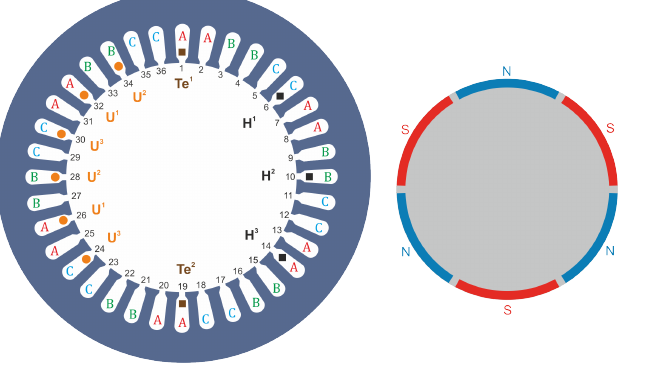
Figure 6. Illustrative drawing showing our developed construction of a BLDC motor: left figure— stator with marked windings and arrangement of Hall sensors H 1 , H 2 , H 3 , additional windings U 1 , U 2 , U 3 and Te 1 , Te 2 temperature sensors; right picture—rotor, with three pairs of magnets glued on the side surface of the rotor.